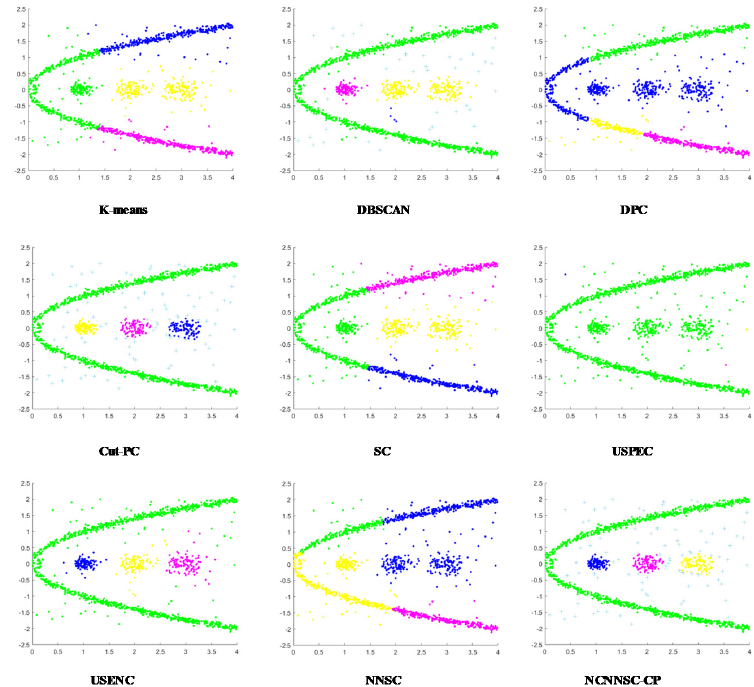
Figure 13. The results of 9 clustering algorithms in D8.